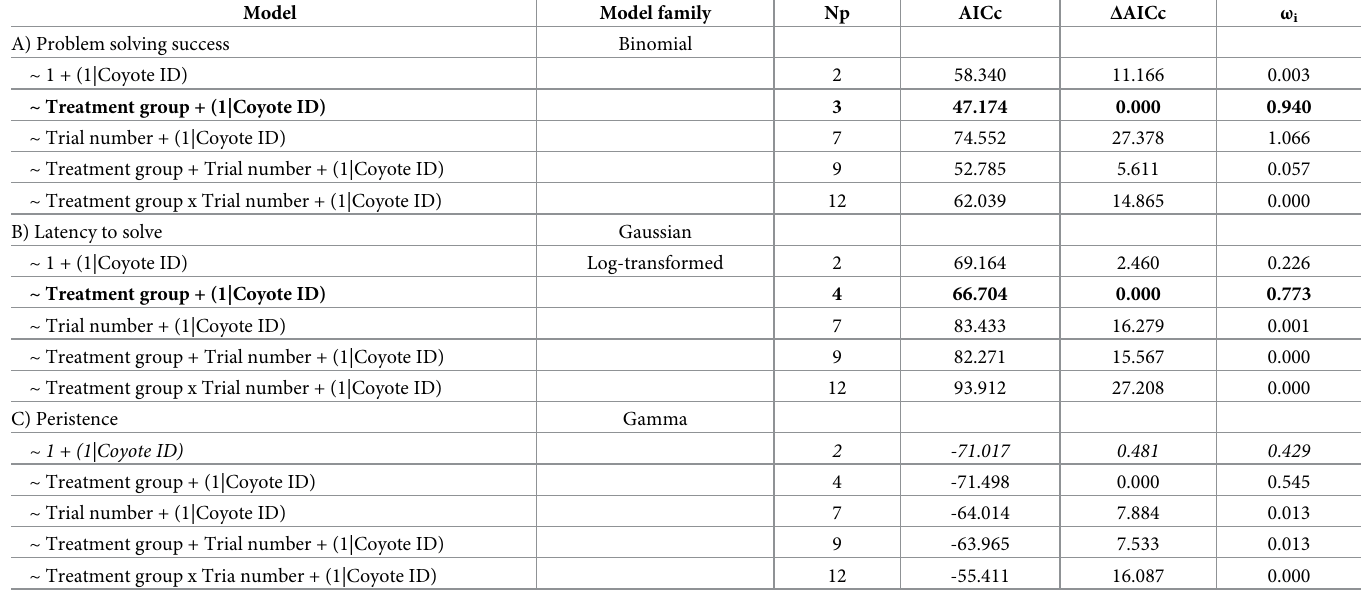
Table 3. Set of models fitted to assess the relationship between treatment group and trial number and (A) problem solving success, (B) latency to solve, and (C) per- sistence. The error distributions used in the models are specified by model family. Model comparison was based on AICc. Np is the number of parameters, Δ AICc is the difference between the candidate model and the model having the lowest AICc, and ω i is the AICc weight of each model (i.e. measure the likelihood that a given model is the best among the candidate models). Models retained based on the lowest AICc value appears in bold, and models retained based on parsimony rules in italic